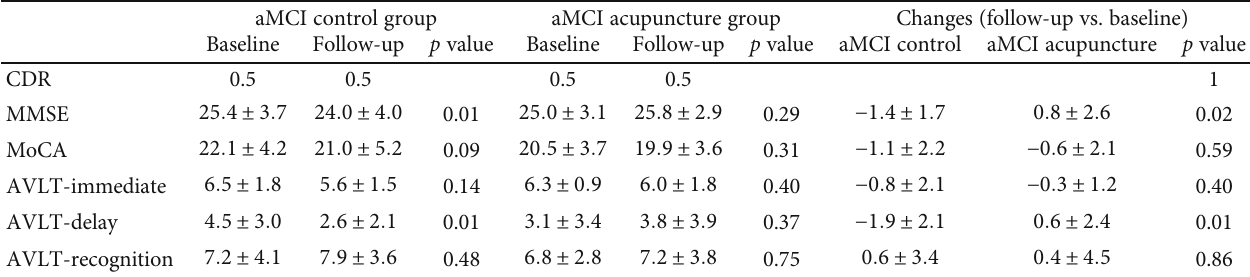
Table 1: Scoring results of neuropsychological